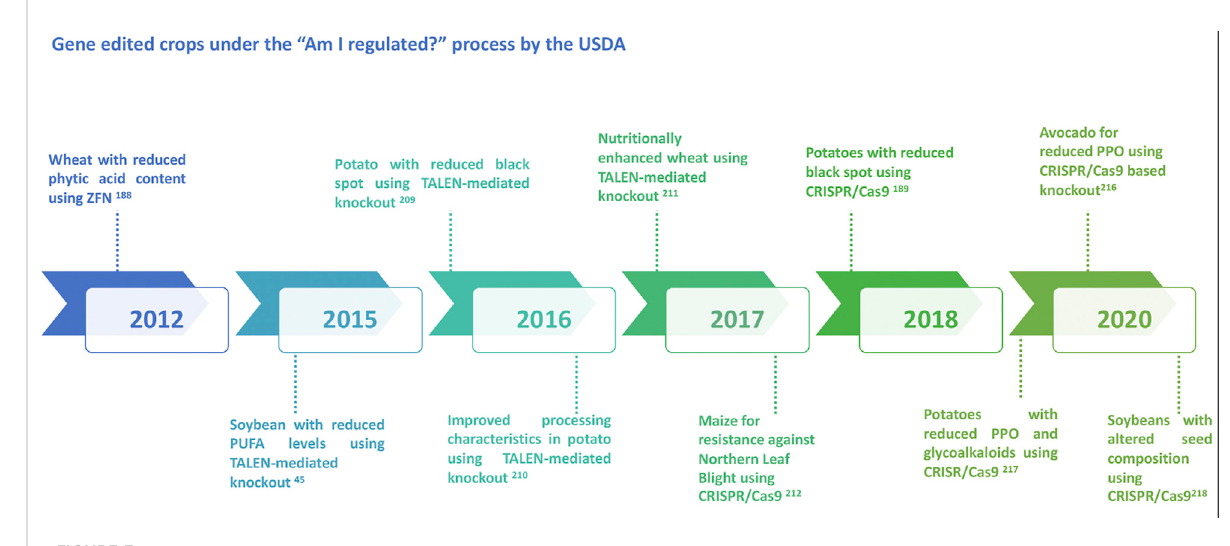
FIGURE 3 Diagrammatic representation of some of the major gene edited crops approved under the “ Am I regulated? ” process by the